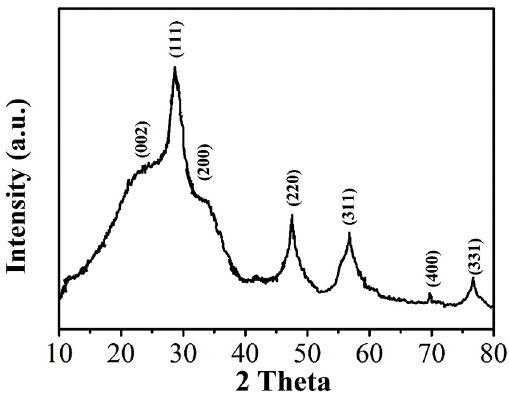
Figure 5: XRD pattern of CA/RGO/Ag-6.